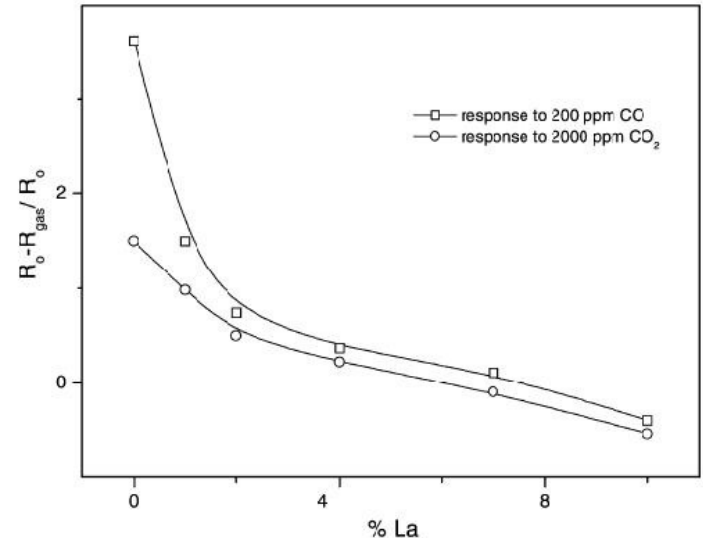
Figure 15. Results demonstrating the effect in changing La concentration on the responsivity of the SnO film, also showing poor discrimination between carbon monoxide 2 and carbon dioxide. Figure adapted with permission from